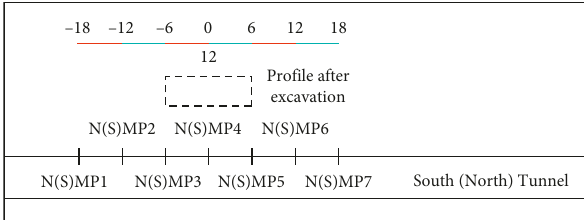
Figure 7: Layout of the monitoring points along the tunnels.